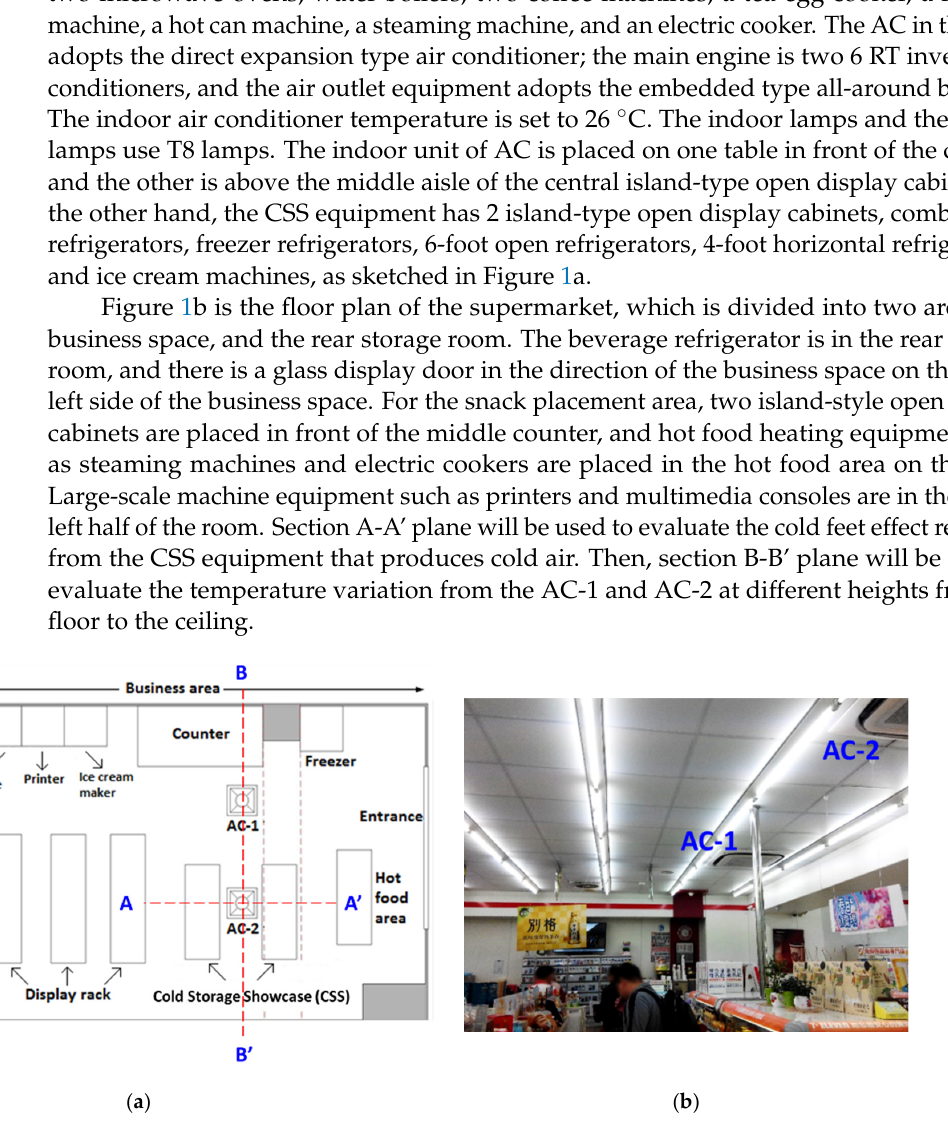
Figure 1. Investigated convenience store; ( a ) AC location; ( b )